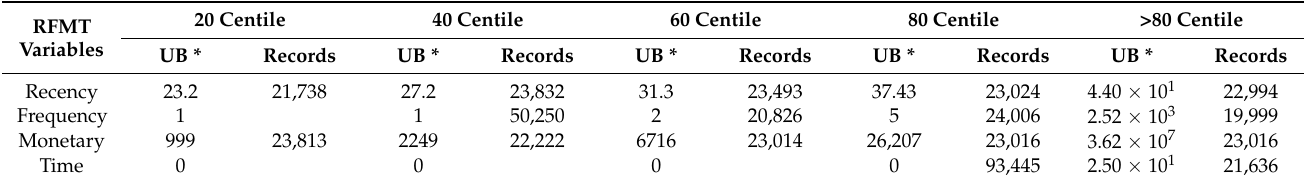
Table 2. Centile upper boundary values of the RFMT variables.